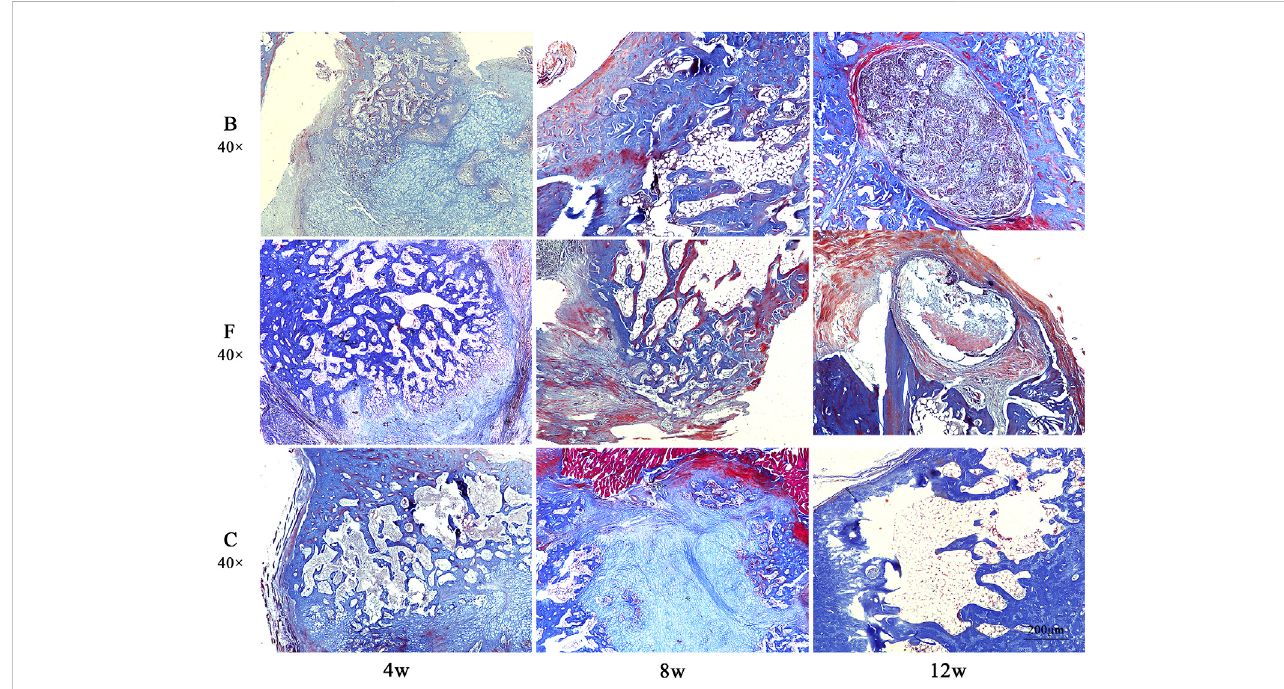
FIGURE 14 TheMassonstainingmapofbonedefects inrats. Thetissues weretakenfor Masson stainingatweeks 4,8and 12after implantation (magni fi cation,×40).